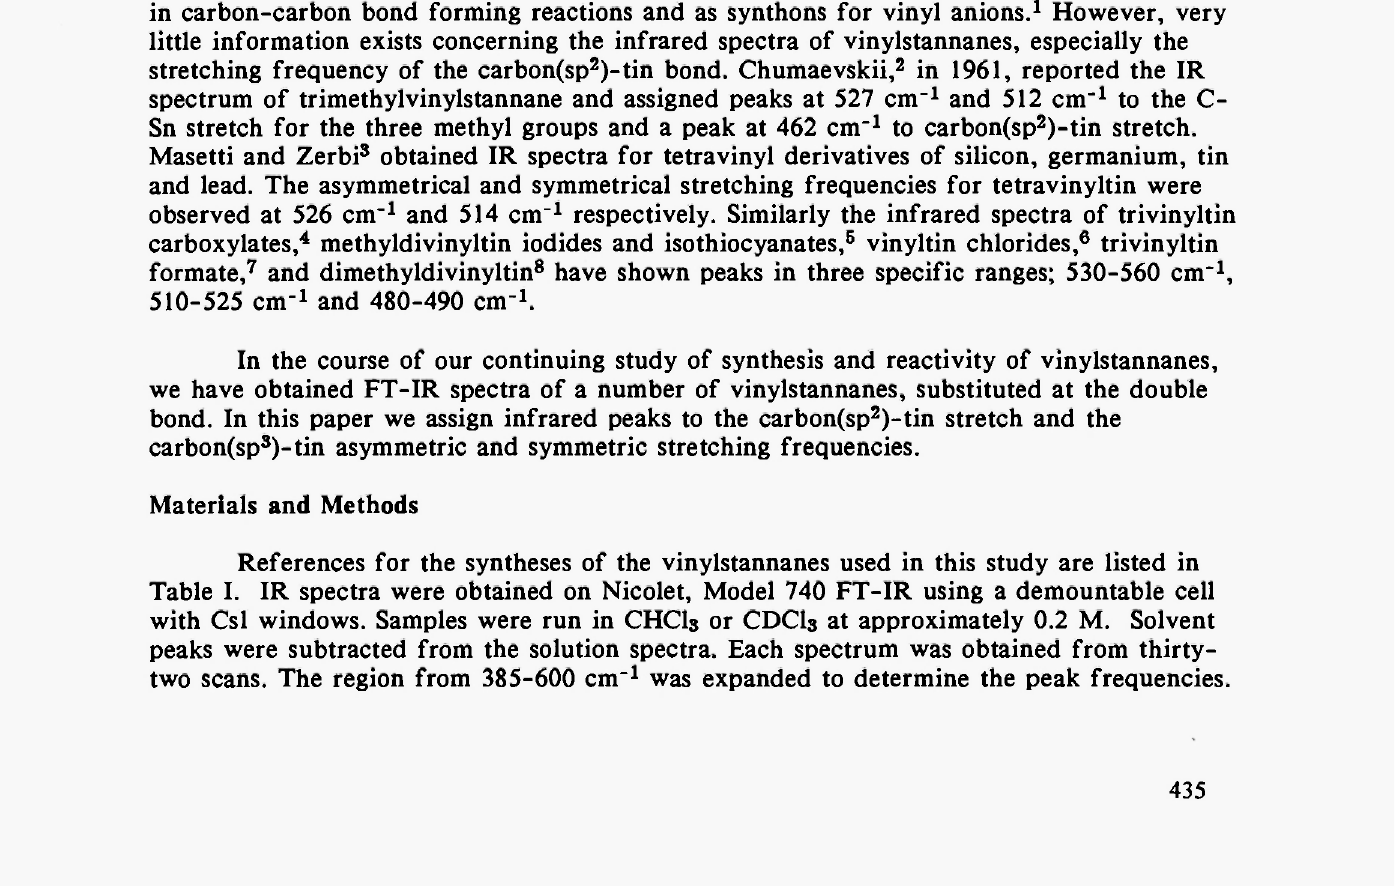
Table I. IR spectra were obtained on Nicolet, Model 740 FT-IR using a demountable cell with Csl windows. Samples were run in CHCI3 or CDCI3 at approximately 0.2 M. Solvent peaks were subtracted from the solution spectra. Each spectrum was obtained from thirty- two scans. The region from 385-600 cm" 1 was expanded to determine the peak